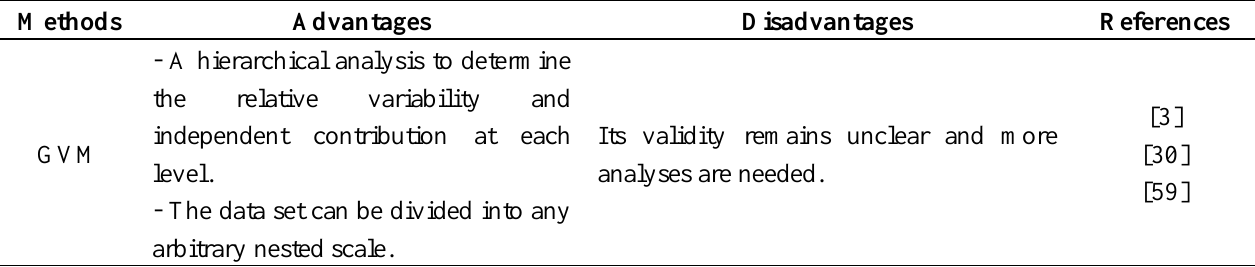
Table 2. Comparison of different methods used to quantitatively describe scale threshold and scale